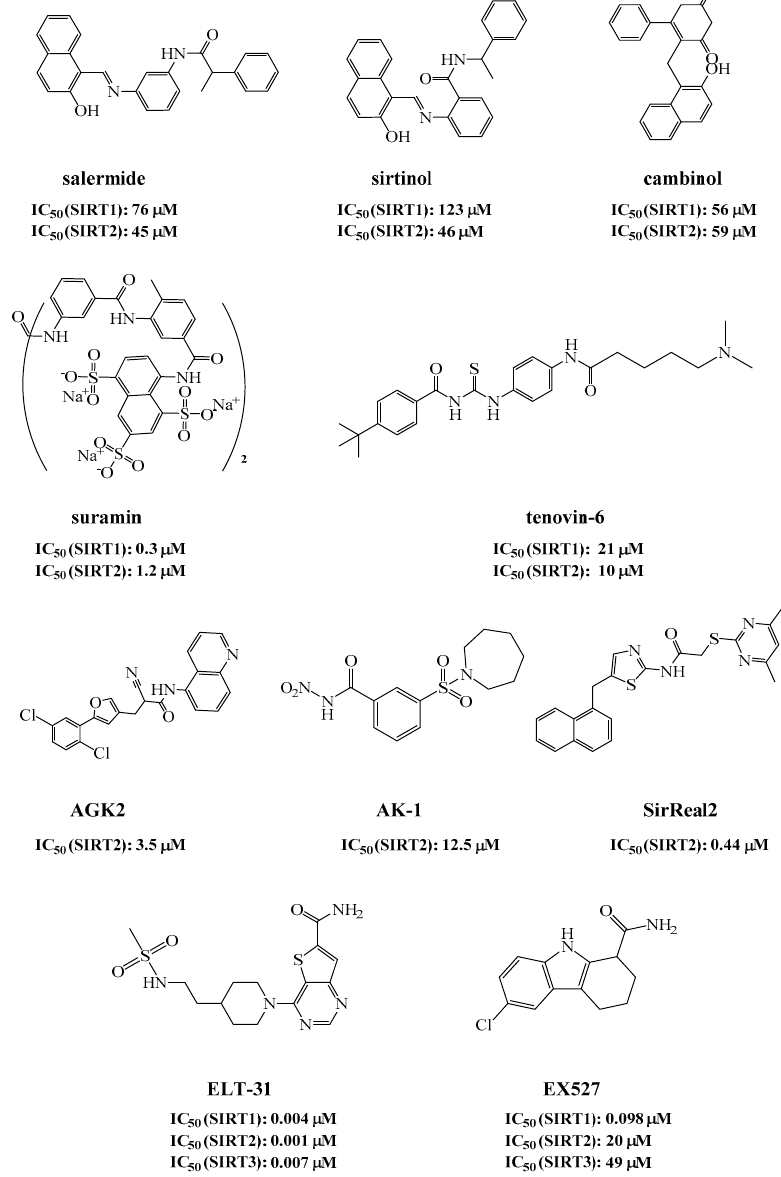
Figure 1. Sirtuin inhibitors.